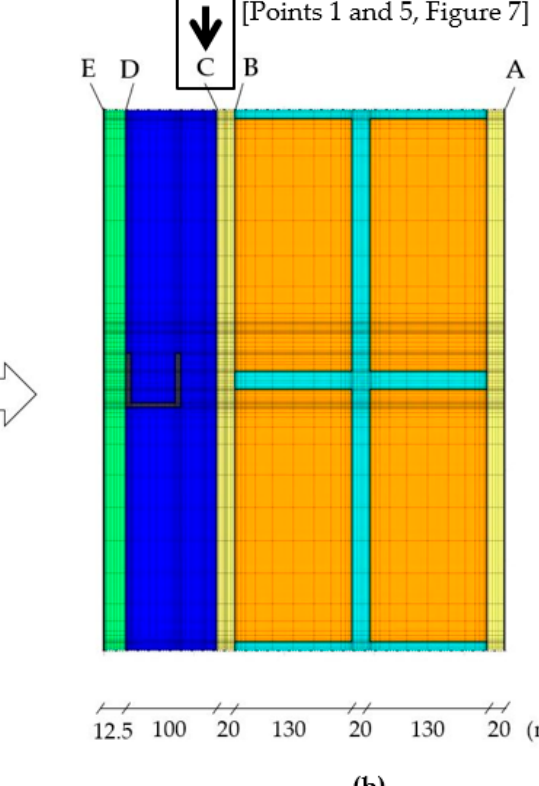
Table 2. Main hygrothermal properties of the chosen materials.